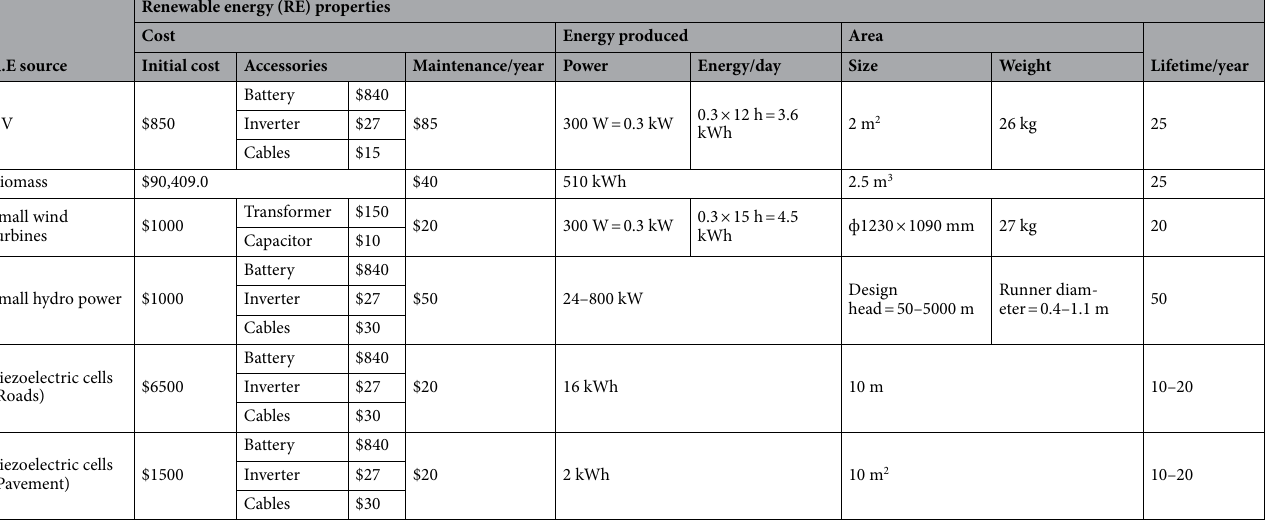
Table 2. Data collected from cross-sectional surveys on the properties of renewable